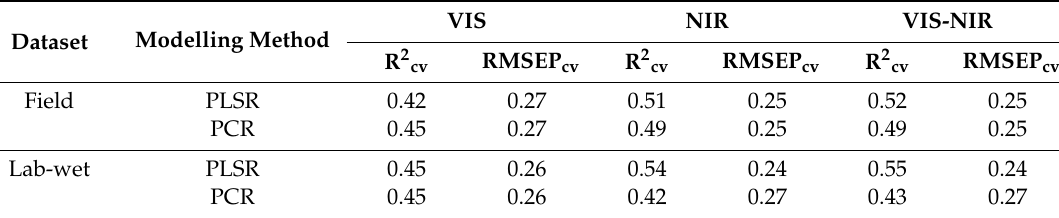
Table 4. Statistics for SOC prediction from field and lab-wet spectra using both PLSR and PCR based on orthogonal signal correction